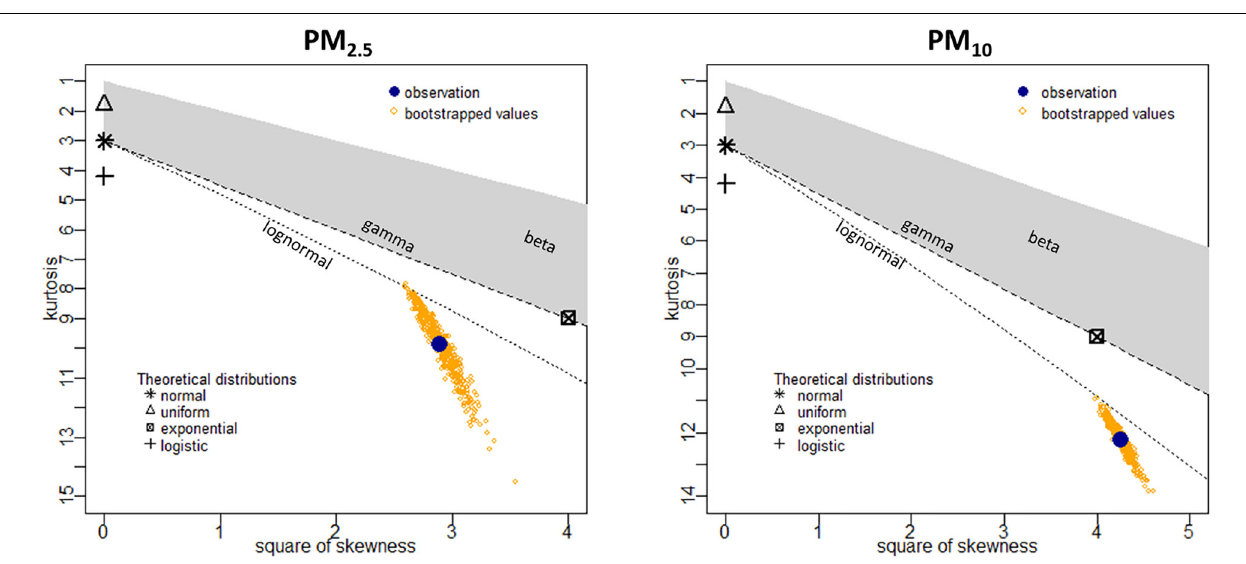
FIGURE 7 | Cullen and Frey graph for PM 2 . 5 (left chart) and PM 10 (right chart) valid measured data. TABLE 1 | Loglikelihood, AIC and BIC indicators for PM 2 . 5 and PM 10 data fitting. PM 2 .